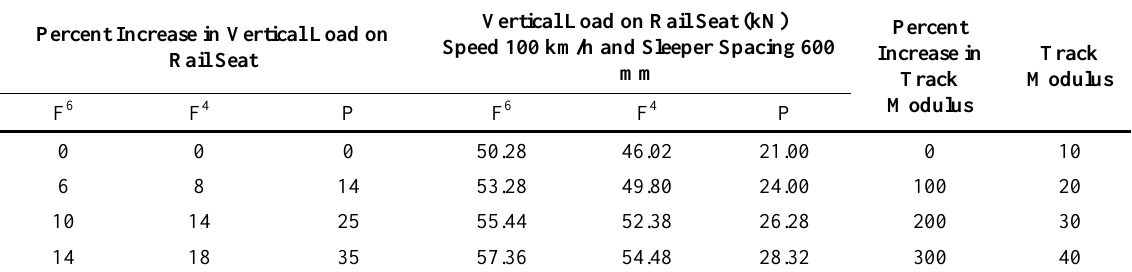
Table 2. Effect of track modulus changes on vertical load on rail seat for speed of 100 km/h and sleeper spacing of 600mm (F 6 , F 4 and P represent the 6-axles freight train, 4-axles freight train and passenger train,